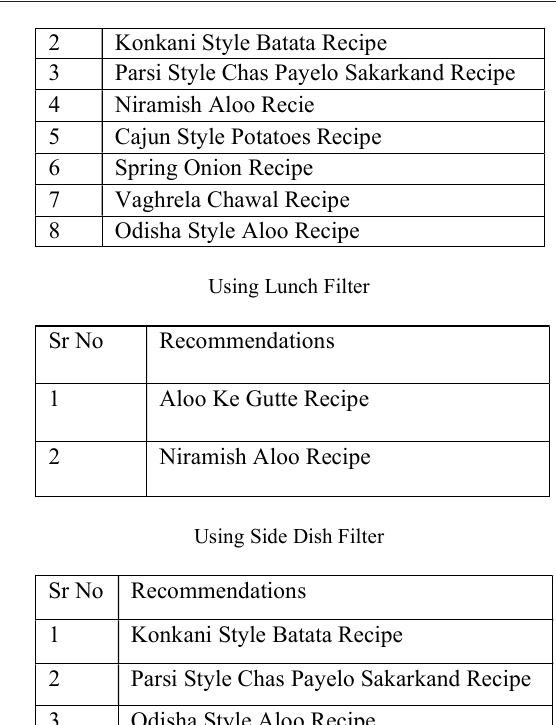
Fig. 3. Flowchart of recommendation